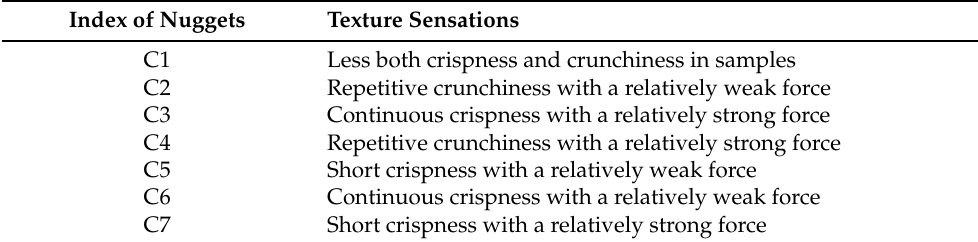
Table 2. Texture sensations of seven chicken nuggets. Compared among nuggets, they were roughly evaluated when blending materials of coating.